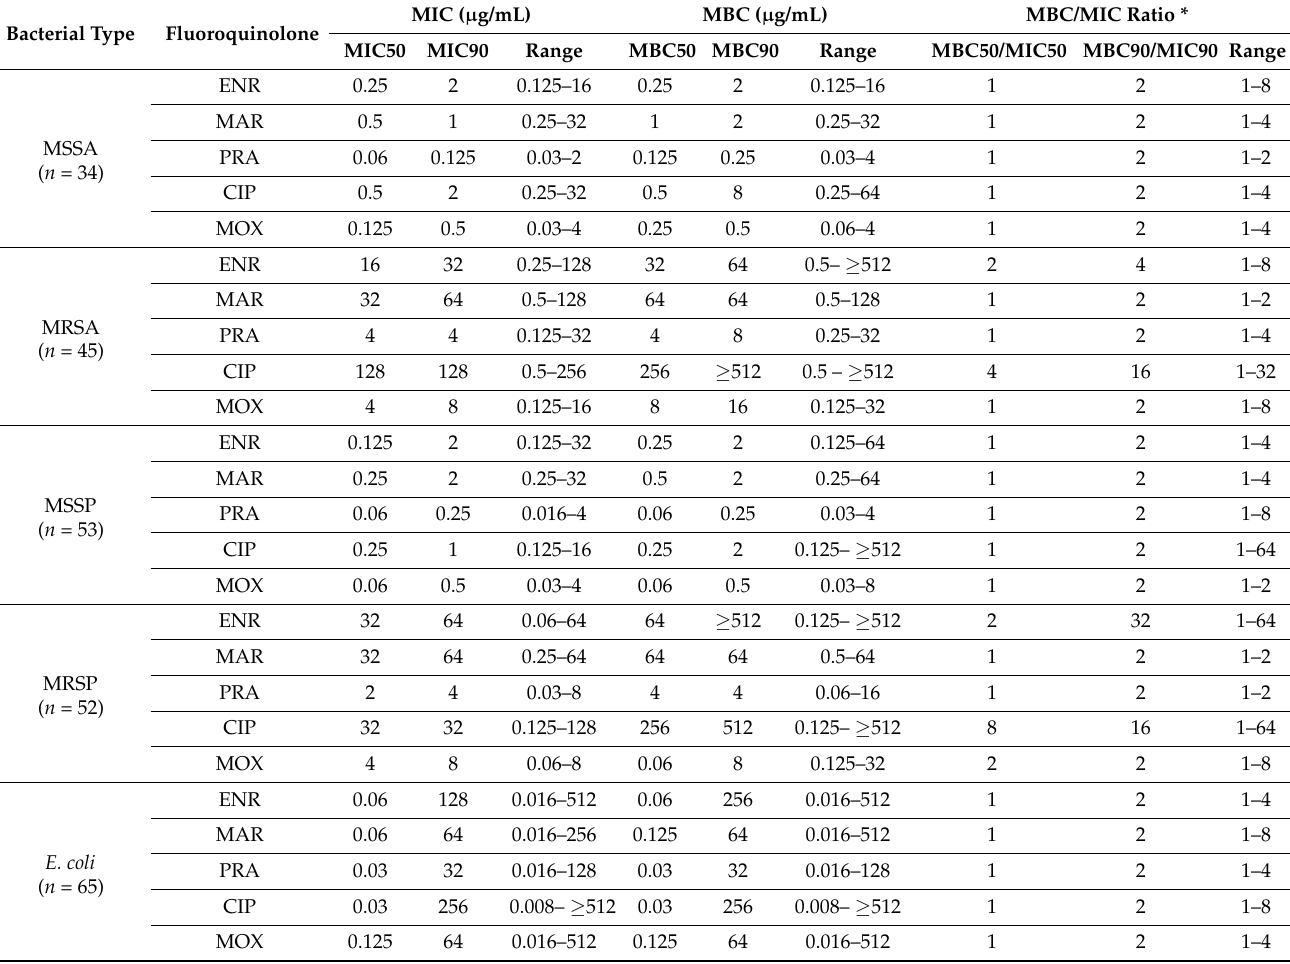
Table 1. MIC, MBC values and MBC/MIC ratios of five fluoroquinolones among a total of 249 isolates of three bacterial species ( S. aureus , S. pseudintermedius , E. coli ) and their subtypes (MS and MR staphylococci), isolated from canine pyoderma and/or wound infection